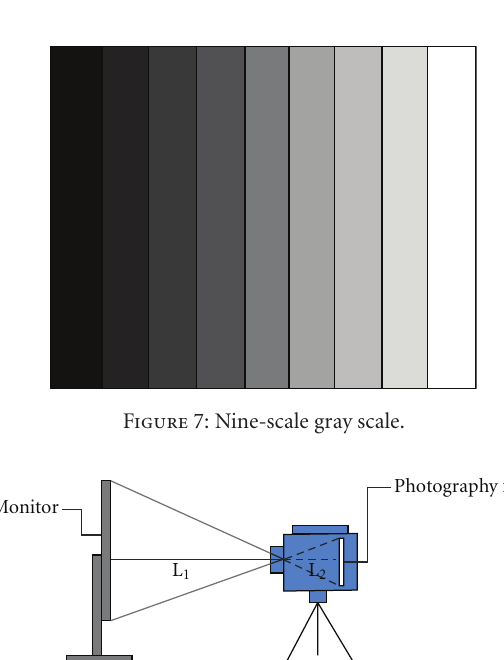
Figure 6: X -axis 2D contour data analysis diagram.